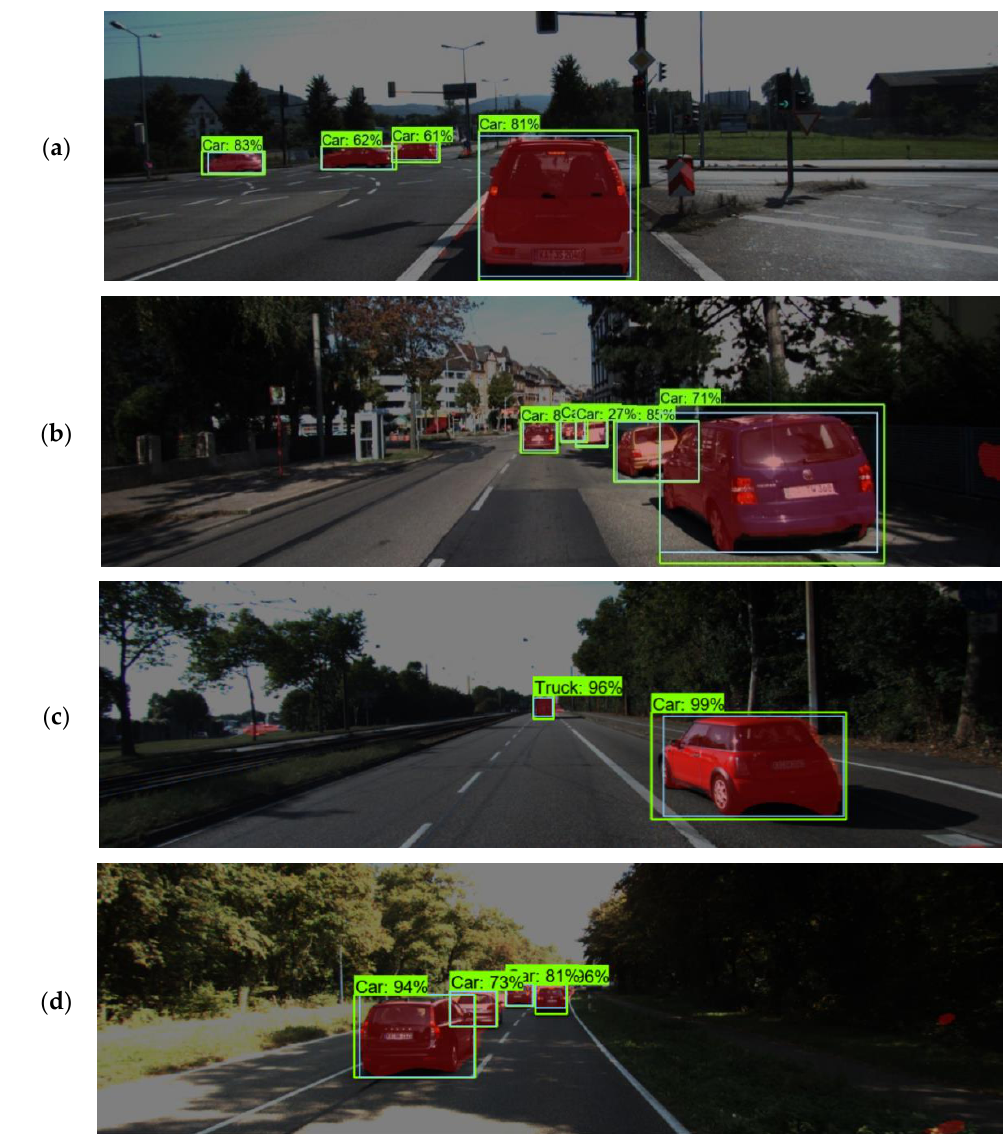
Figure 5. The green boxes are the detection output of the basic target detection algorithm (SSD, YOLOv3spp), and the light-sky-blue boxes are the output of SegSSD and SegYOLO, the target regions in mask map of SegBlock are marked by red. ( a , b ) are the results of YOLOv3spp and SegYOLO, ( c , d ) are the results of SSD and SegSSD.